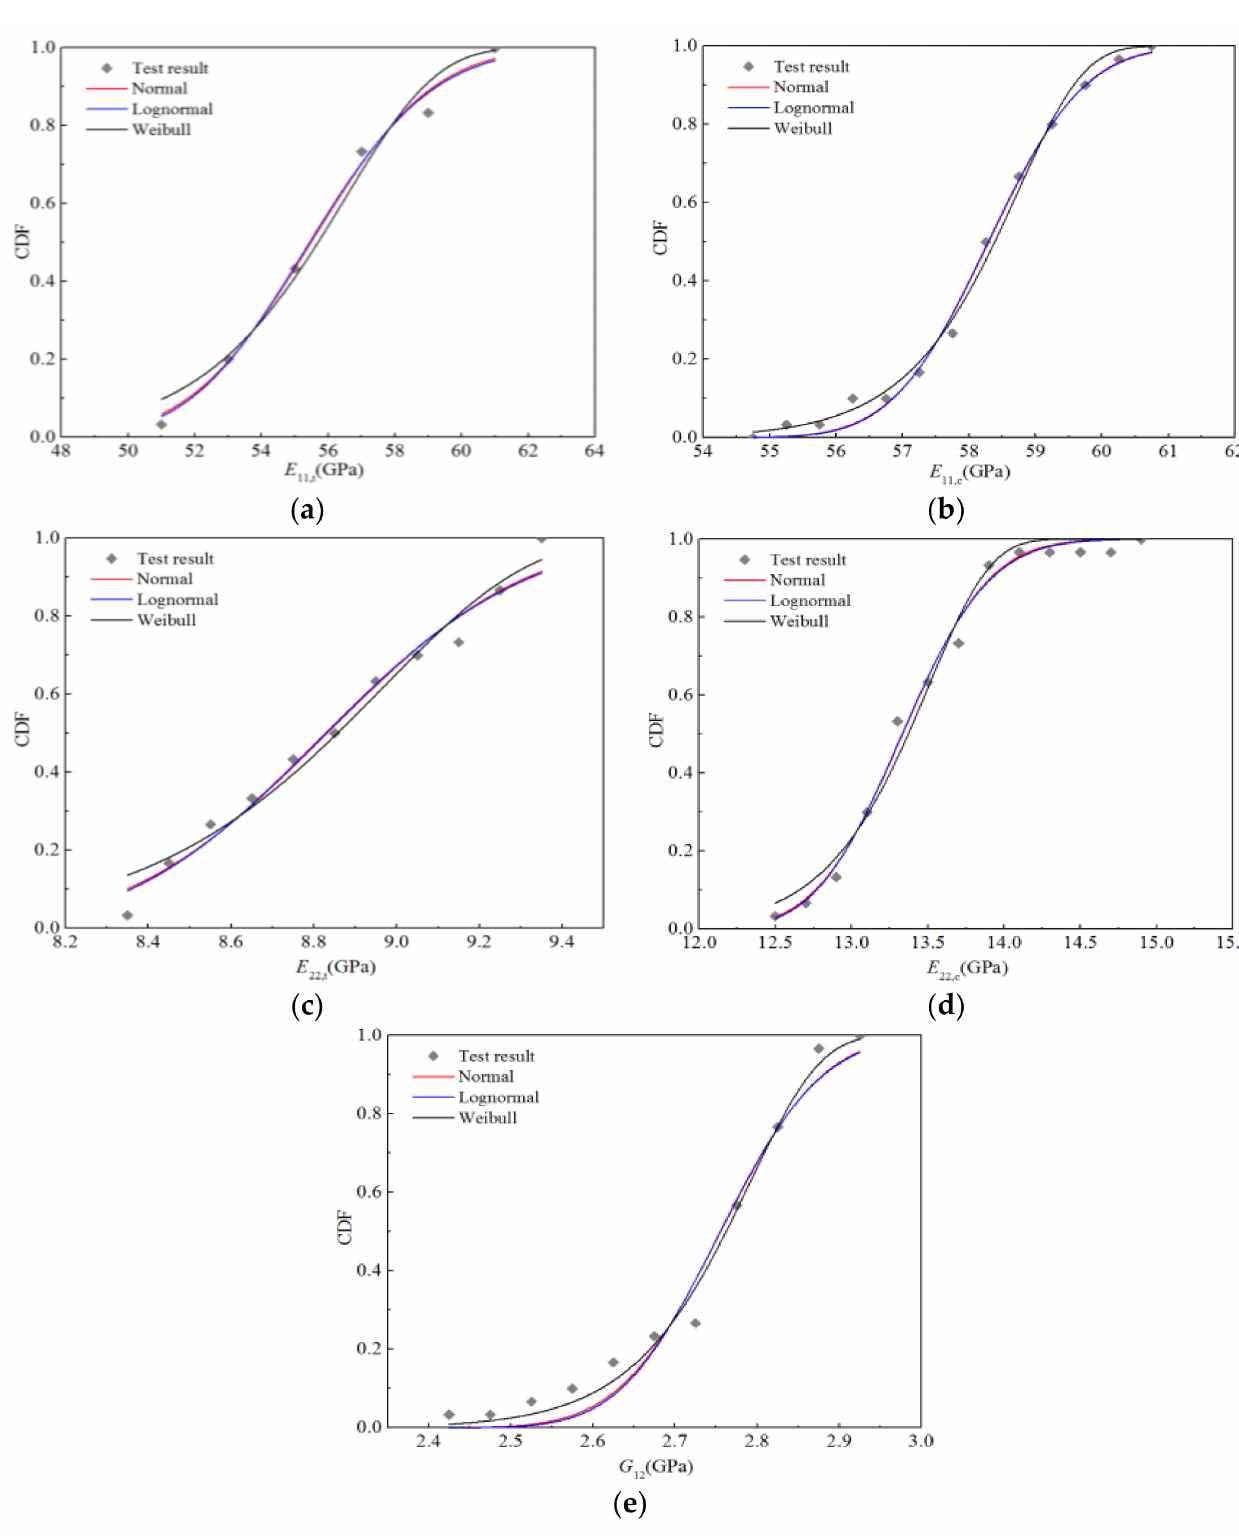
Figure 10. Functional fitting curves for the strength properties of H-GFRPs in a humid and hot environment. ( a ) E 11,t , ( b ) E 11,c, ( c ) E 22,t , ( d ) E 22,c, ( e ) G 12